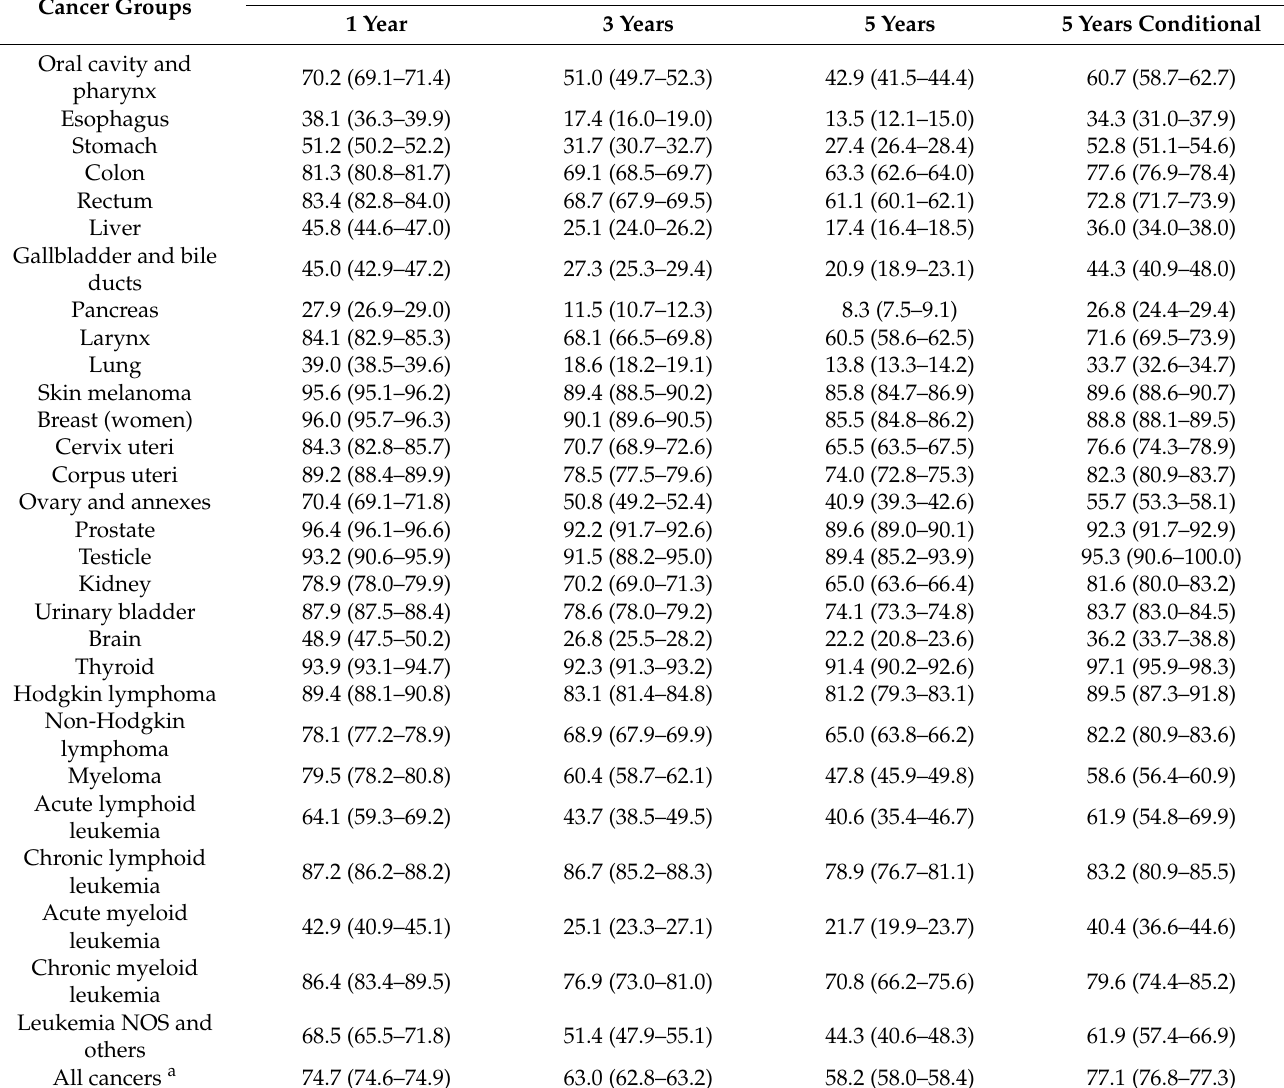
Abbreviations: NOS, not otherwise specified. a Excluding non-melanoma skin